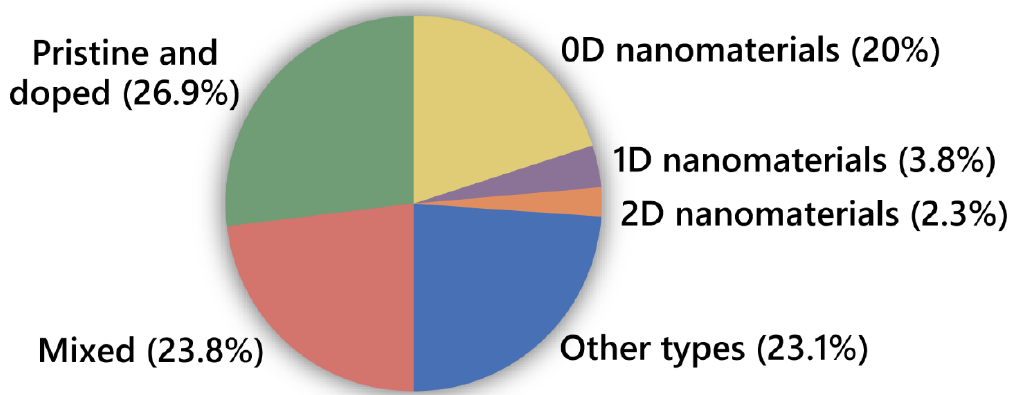
Figure 9. Distribution of the published articles (around 150) according to the different materials used to obtain the GQDs- based electrochemical sensors. Data obtained from Web of Science accessed in June 2021 using the keywords “graphene quantum dots” and “electrochemical sensors”.